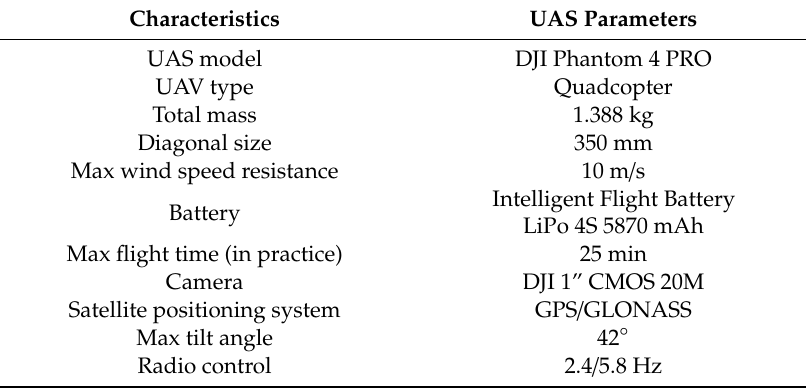
Table 1. Technical specification of DJI Phantom 4 Pro